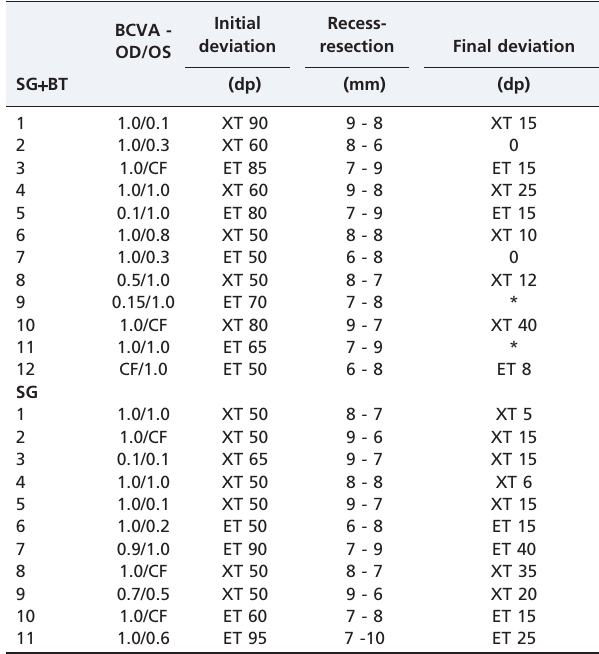
Table 2 - Numerical data for the variables.